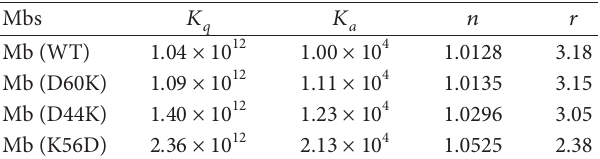
T 5: e comparison of experimental data of Mb (WT) and Mb mutants, respectively,